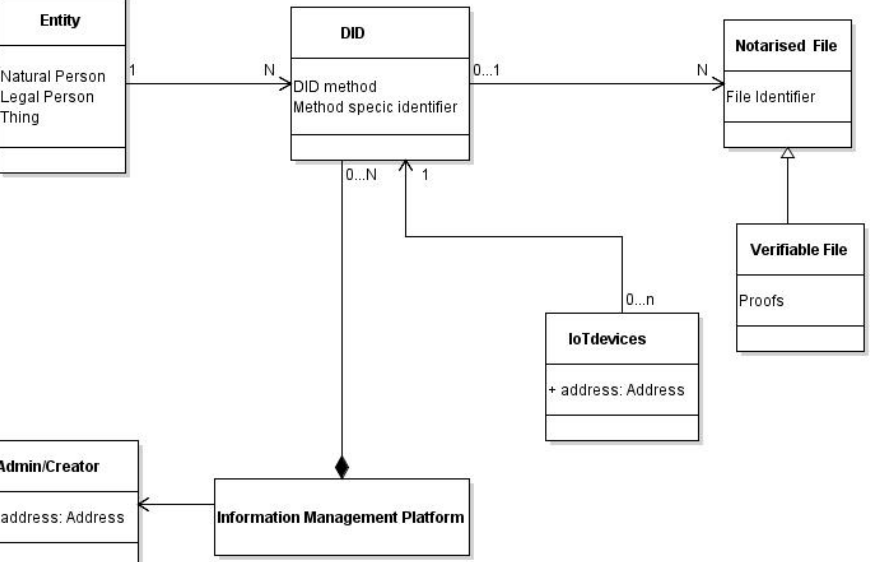
Figure 4. Class Diagram of the whole system without taking into account the methodology used for its